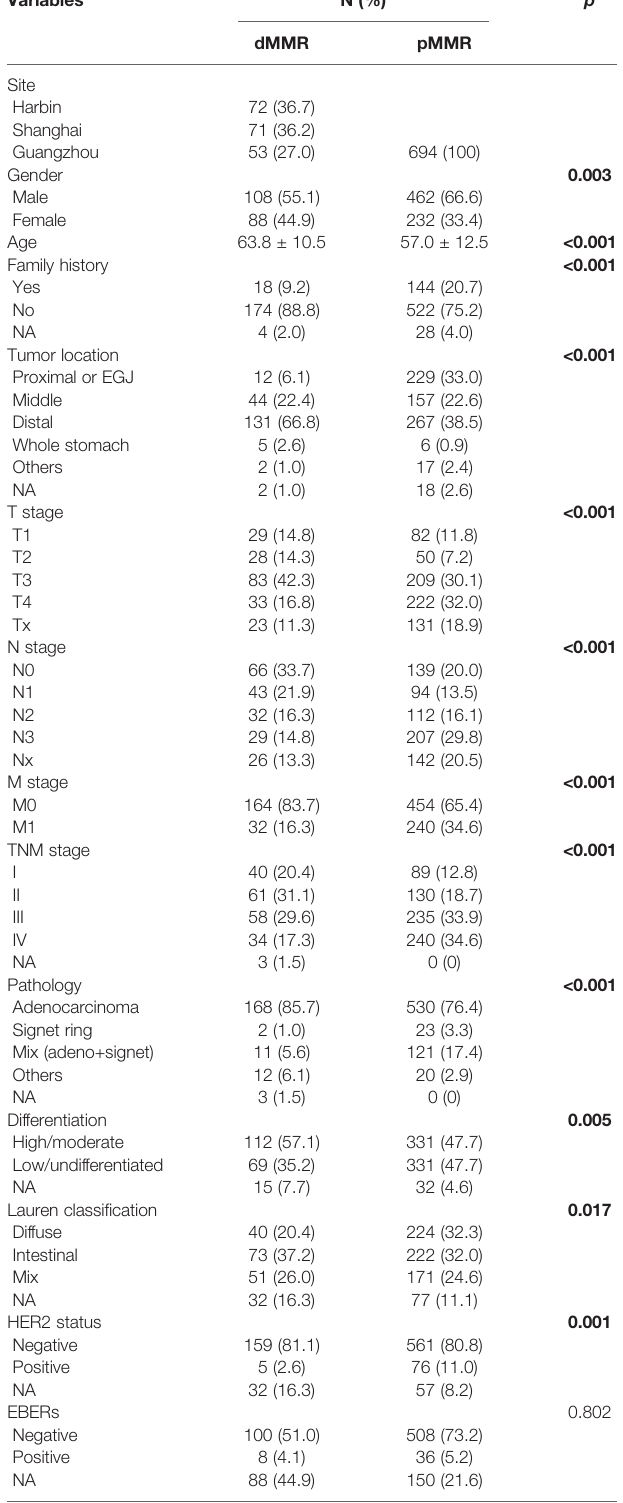
TABLE 1 | Clinical and pathological characteristics of dMMR/MSI-H gastric cancer.